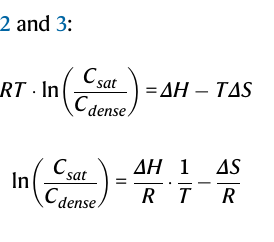
temperature is increased to above a threshold, i.e., transition temperature . After phase separation has occurred, the aqueous phase still contains solvated FG domain molecules at a concentration equal to C sat . Right: a phase-contrast micro- scopyimageshowingatypicalphase-separatedstate. b , c Dilutionsofprf.GLFG 52×12